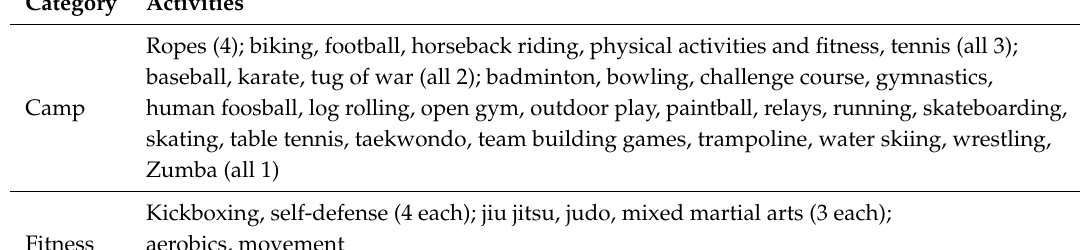
table tennis, swimming, whitewater rafting (2 each); biking, bocce, climbing, cricket, dance, karate, self-defense, skating, snow tubing, tennis, walking (1 each) Badminton, cricket (4 each); bounce house, hiking, self-defense, swimming, table tennis, tennis (3 each), biking, folkdance, Frisbee, horseback riding, obstacle course, skiing, volleyball, yoga Irregular (2 each); baseball, bowling, golf, horseshoes, ice skating, karate, laser tag, physical activities, tug of war, wrestling (1